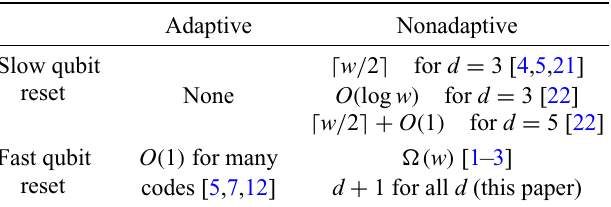
FIG. 1. Different fault-tolerant methods for measuring X ⊗ 4 . (a) Shor’s method. Prepare a four-qubit cat state and then detect correlated errors using an extra ancilla qubit (blue). Apply sub- sequent transversal gates to the data only when the detection outcome is trivial. (b) DiVincenzo-Aliferis decoding method. Couple the data qubits with an unverified cat state. Then apply the decoding circuit (blue) followed by qubitwise measurements, the outcomes of which give the syndrome and information about potential correlated data errors. This method has been extended to measure an arbitrary-weight stabilizer of a distance-three code (Supplemental Material of Ref. [5]). (c) Flag method. Extract the syndrome into an ancilla qubit, which is protected by a flag gad- get (blue). A single fault, e.g., X , on the syndrome ancilla can propagate into correlated data errors, e.g., X ⊗ 2 . Such correlated errors are signaled by a nontrivial measurement outcome on the flag ancilla, and can be diagnosed using subsequent syndrome measurements.